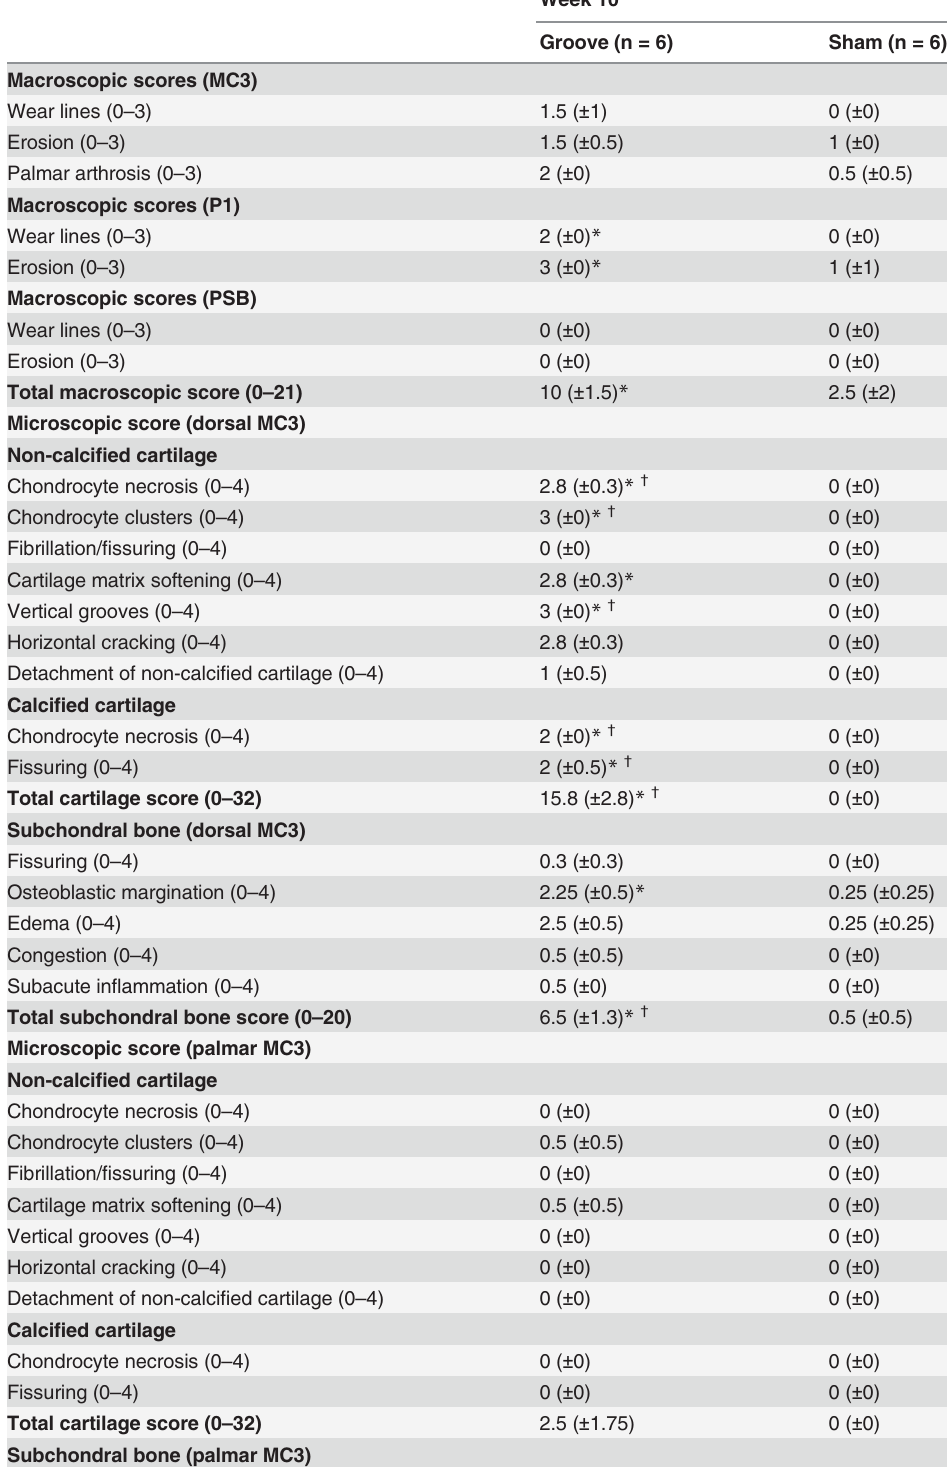
Table 2. Median macroscopic and microscopic scores ( ± median absolute deviation) for groove and sham joints at week